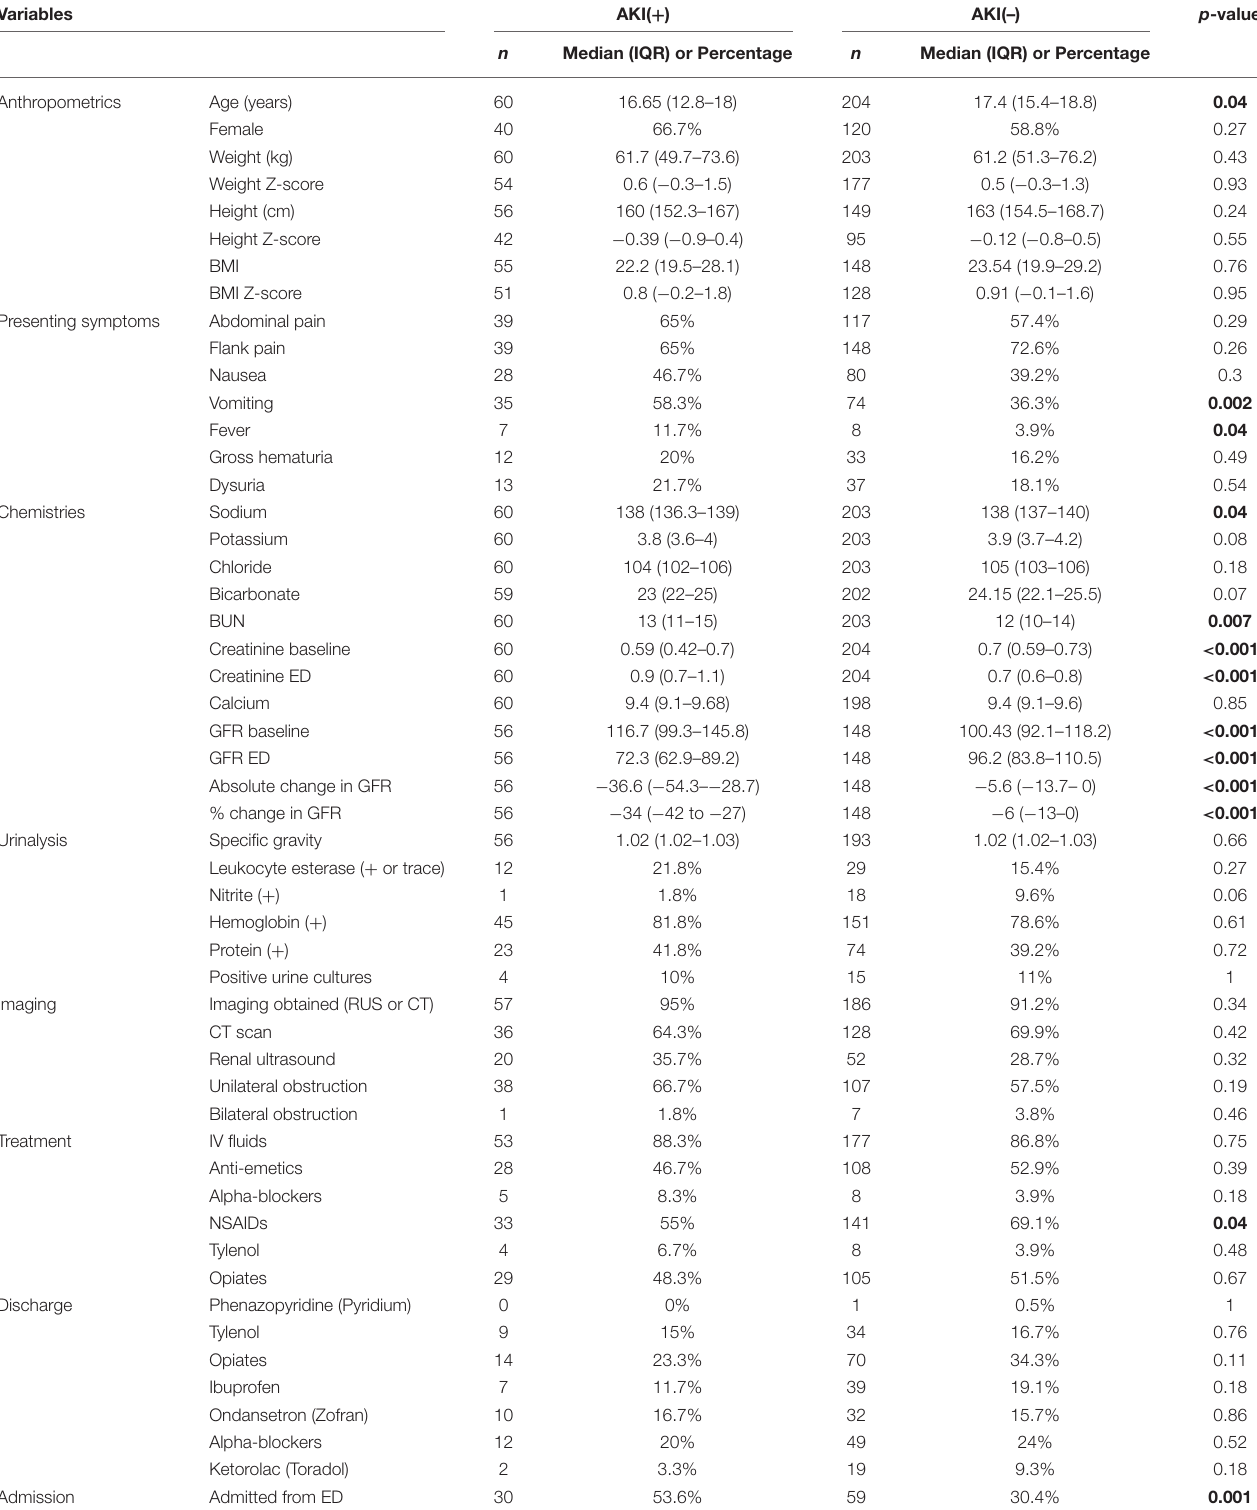
TABLE 2 | Comparison of AKI( + ) and AKI(–)